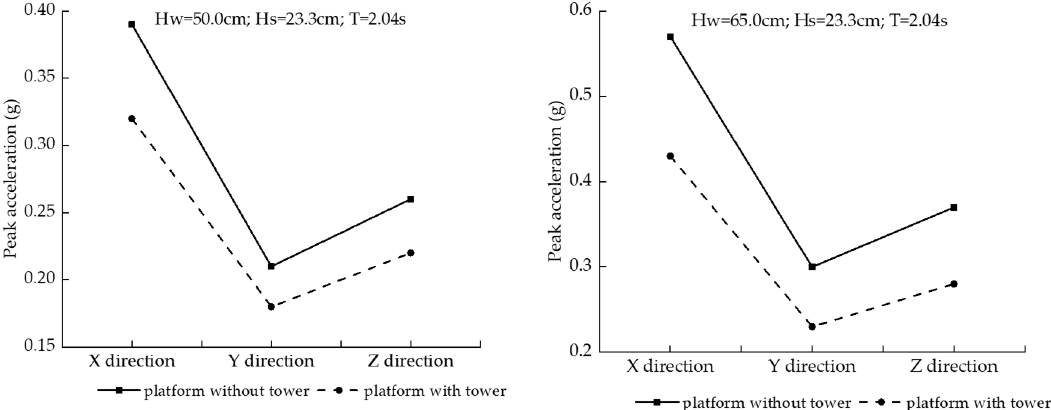
Figure 19. Comparison diagram of acceleration at the monitoring points on the top face of the plat- form with and without the tower.